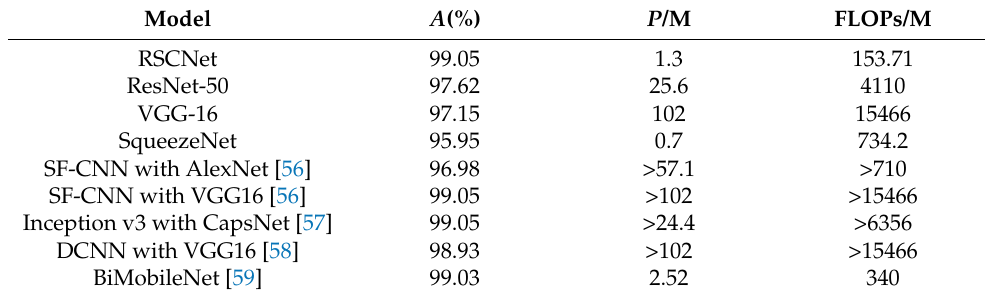
Table 8. Results of various models on UCMerced_LandUse dataset. The training data rate is 0.8.